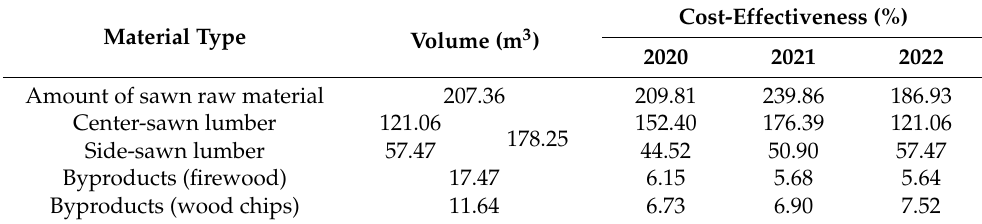
Table 11. Cost-effectiveness ( E p ) of the sawing process according to the variant